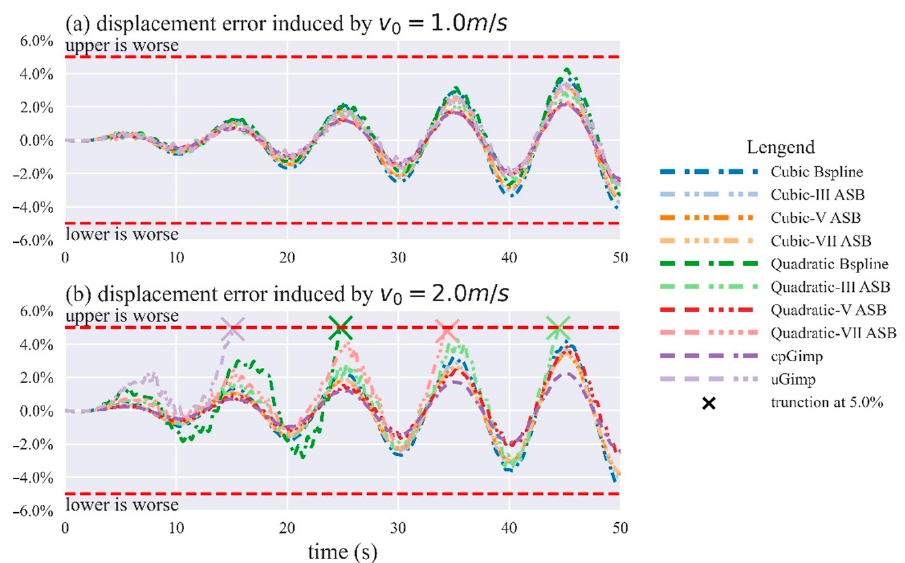
Figure 8. D continuum bar vibration (the free-end particle) for variations of the MPM algorithm: ( a ) the relative error of displacement against the analytic solution under v 0 = 1.0 m/s, ( b ) the relative error of displacement against the analytic solution under v 0 = 2.0 m/s. For clarity, some series are truncated when their relative error increases beyond 5.0%.